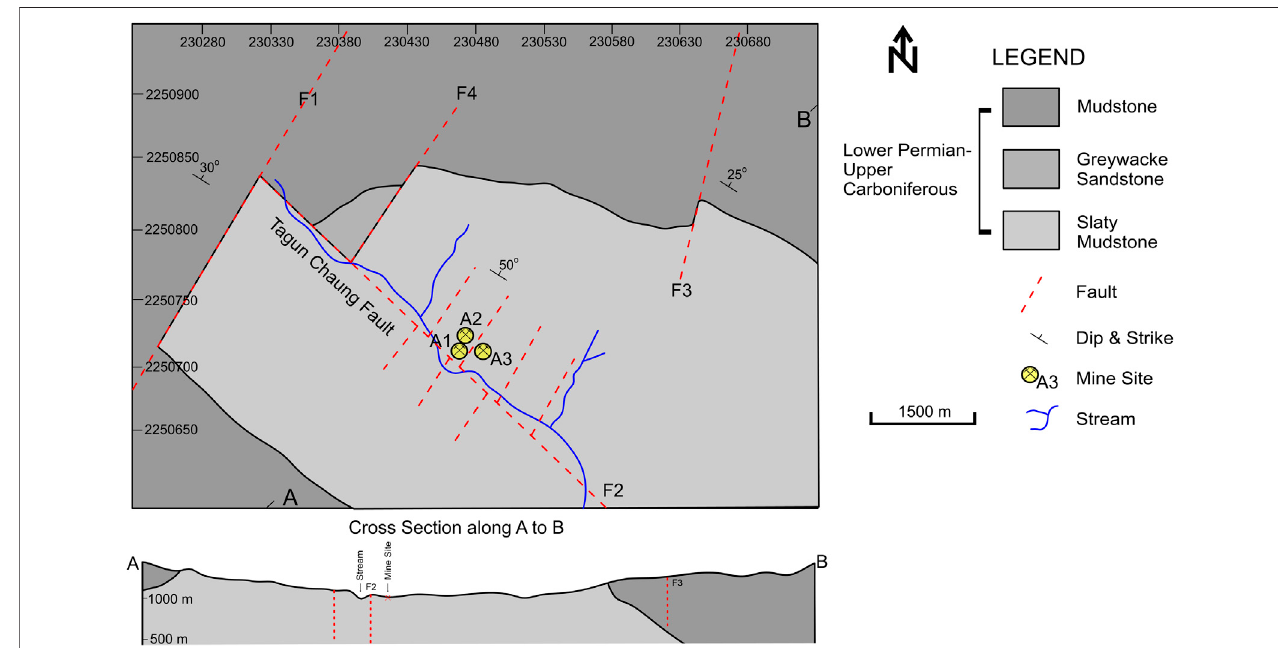
FIGURE 4 | Geological map of the Shwetagun gold deposit, Modi Taung-Nankwe gold district, Myanmar. Abbreviations: A1 (cid:1) adit-I, A2 (cid:1) adit-II, A3 (cid:1) adit-III.